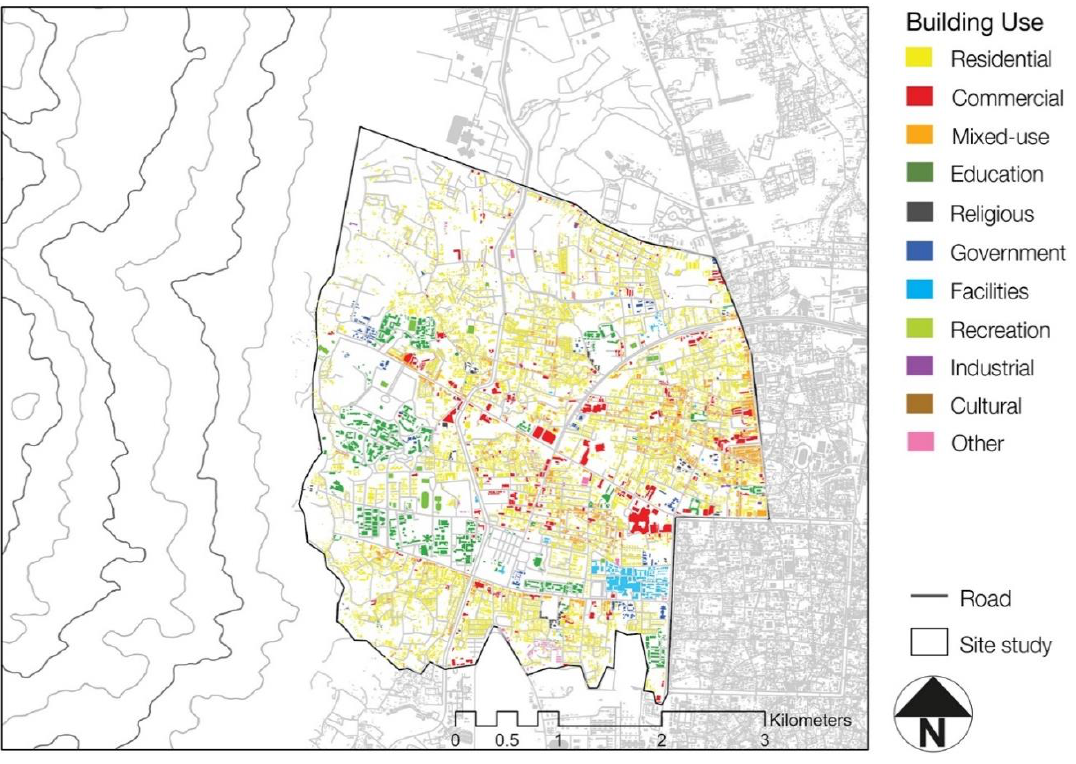
Figure 3. Building uses in the study area (Source: Authors).